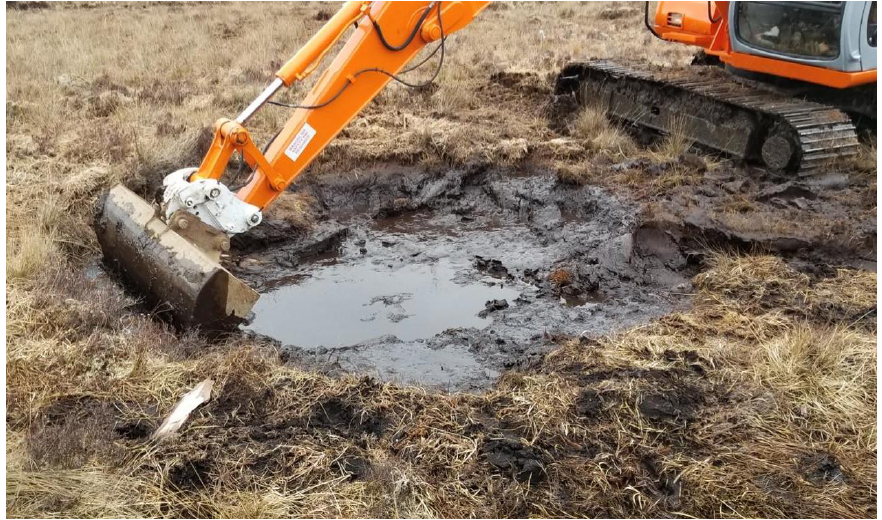
Figure A1. View of the 4-m diameter crater from 1985, drained with a channel shown to the down sloping terrain on the right.